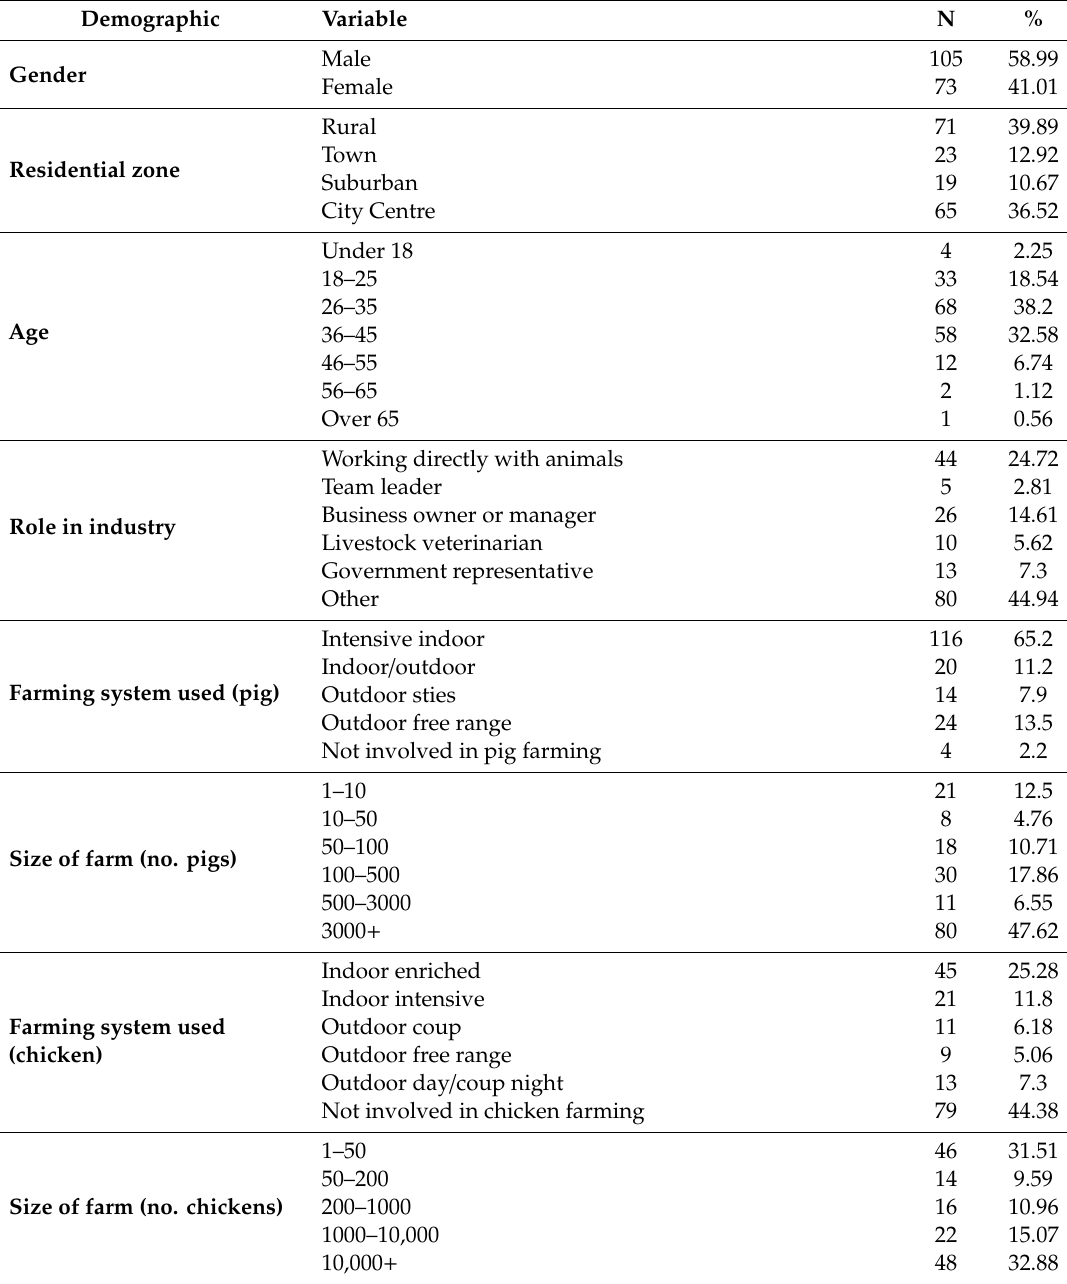
Table 1. Description of respondent